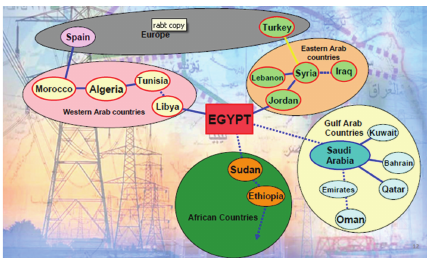
Figure 10: Interconnection transmission